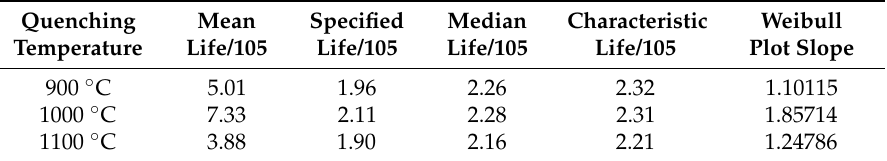
Table 4. Typical values of the rolling contact fatigue (RCF)